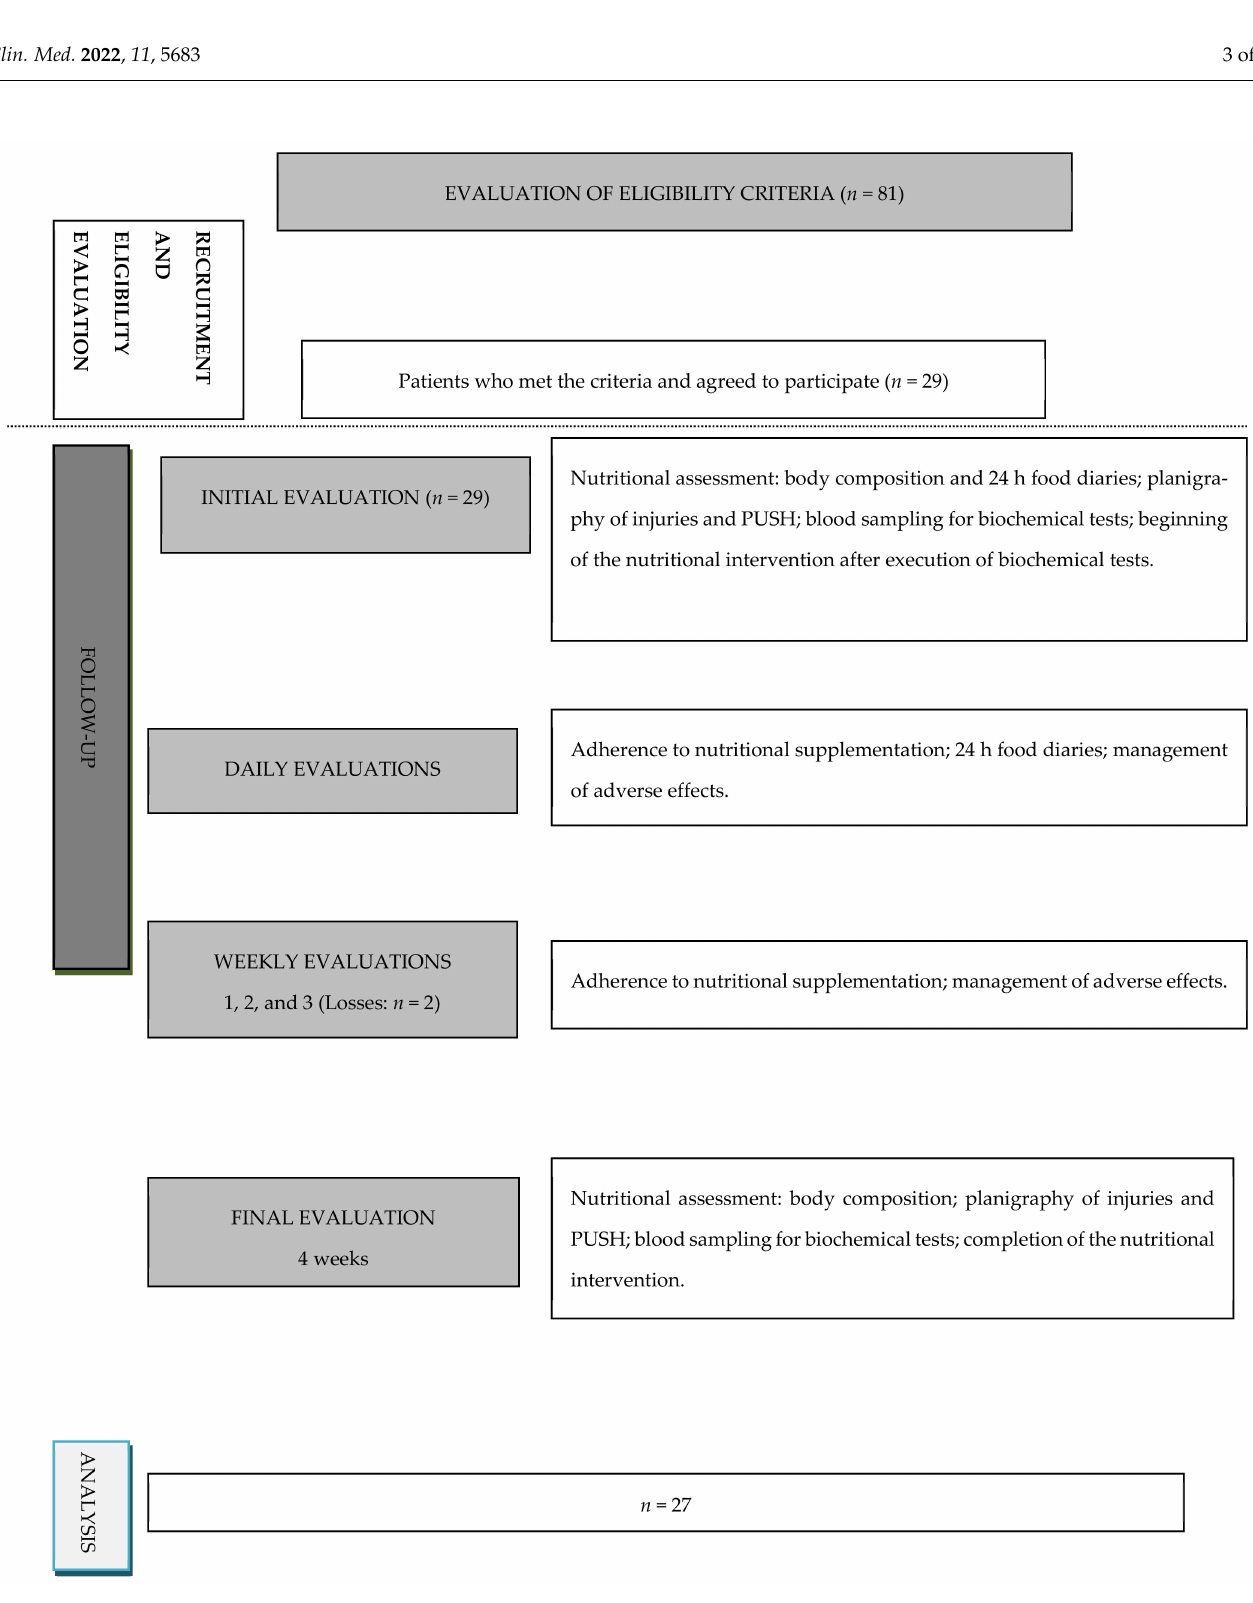
Figure 1. Flowchart showing care and follow-up of the patients analyzed in the